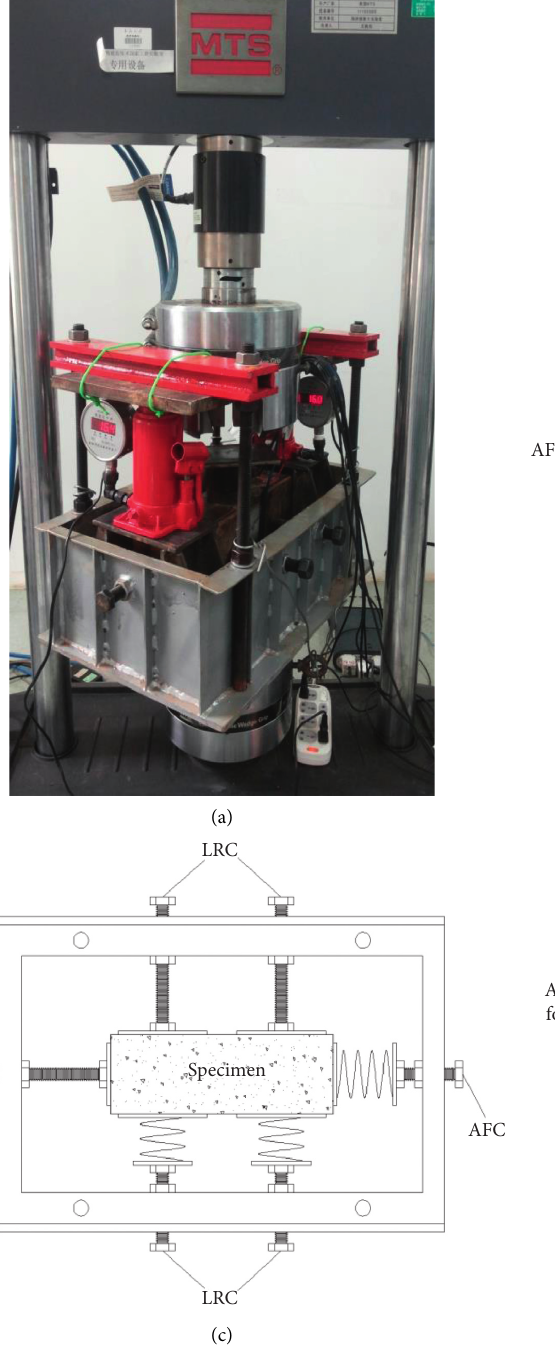
Figure 2: Schematic diagram of the testing system: (a) overall view; (b) exploded view; (c) top view; (d) side view of specimen’s mechanical boundaries and location PZT